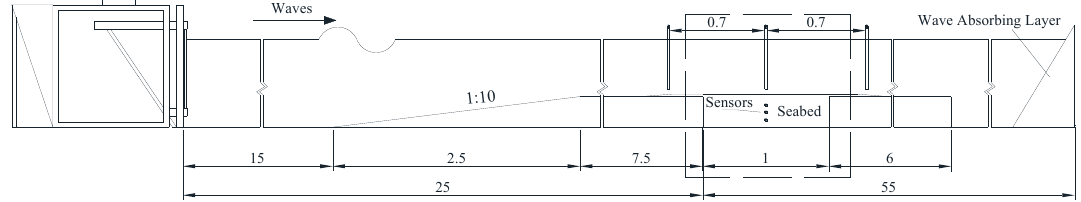
Figure 1. Wave flume setup (unit: m).